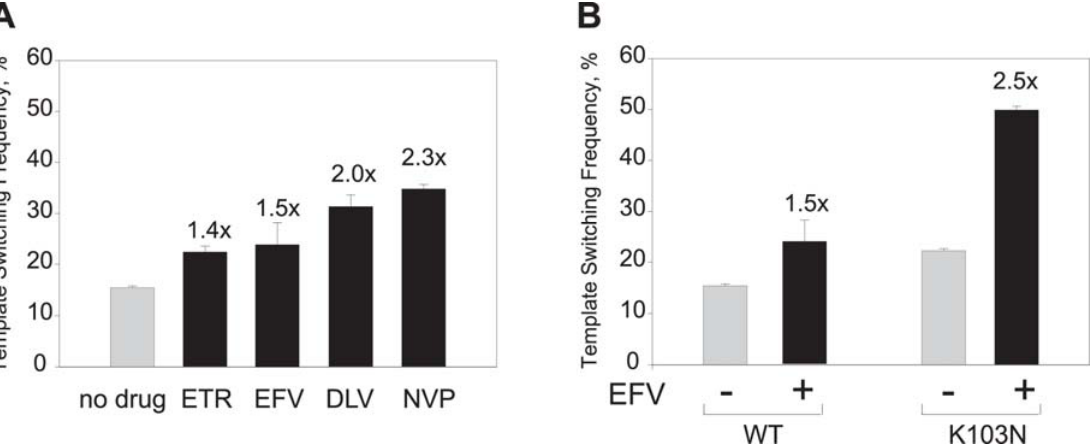
Figure 5. Effect of different NNRTIs on the frequency of RT template switching by wild- type and K103N mutant RTs (A) The effect of NNRTI treatment on the template switching frequency by wild type HIV-1 RT is dependent on the affinity of NNRTI to the RT. (B) Effect of decreased affinity of EFV to the drug resistant K103N mutant RT on the template switching frequency. Figure represents data described in